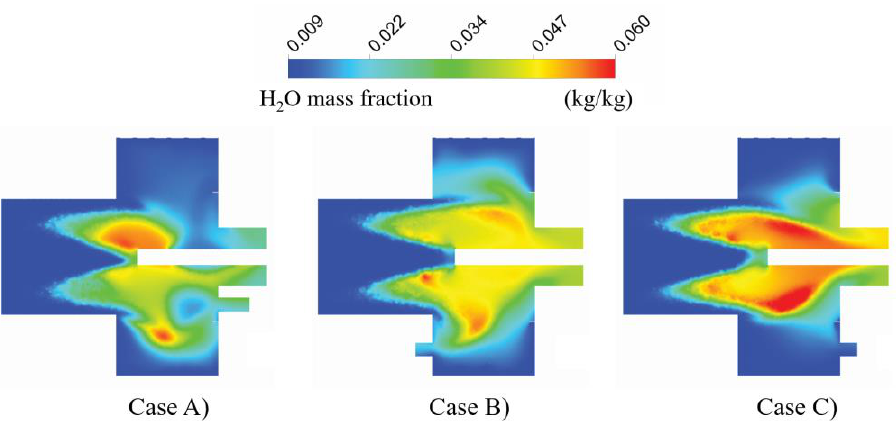
Figure 6. Moisture fraction distribution at the Y-Z plane (to provide better insight into the evaporation process, the maximum value of moisture fraction has been restricted to 0.06).